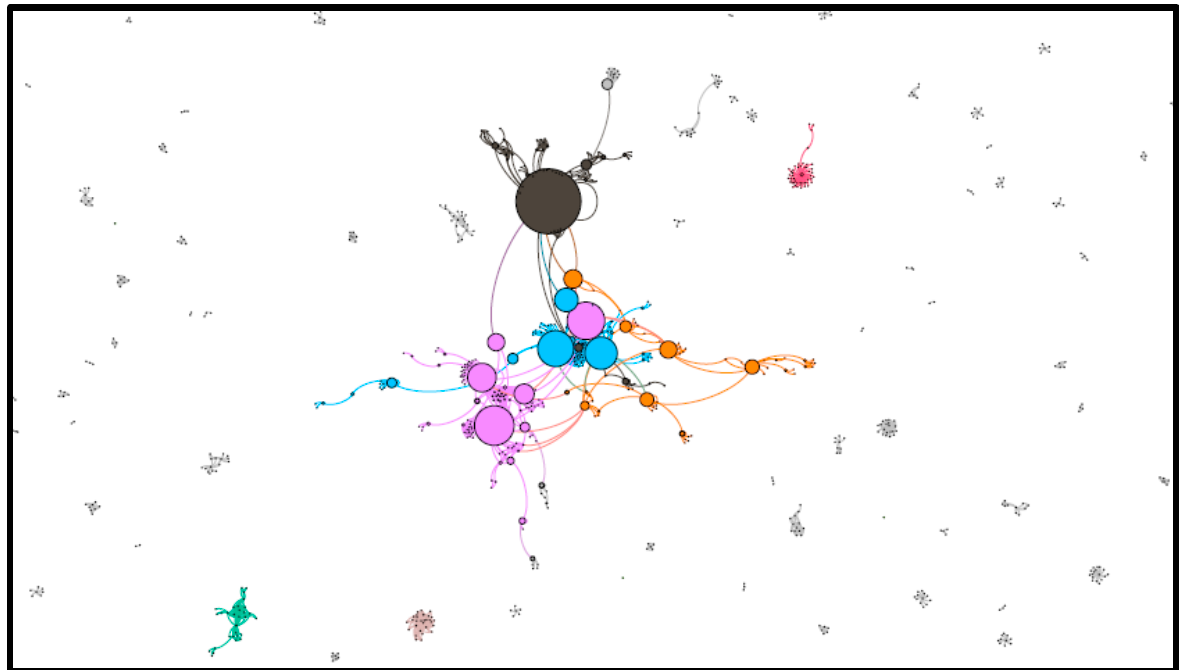
Figure 4. Network visual of 3 February 2022.